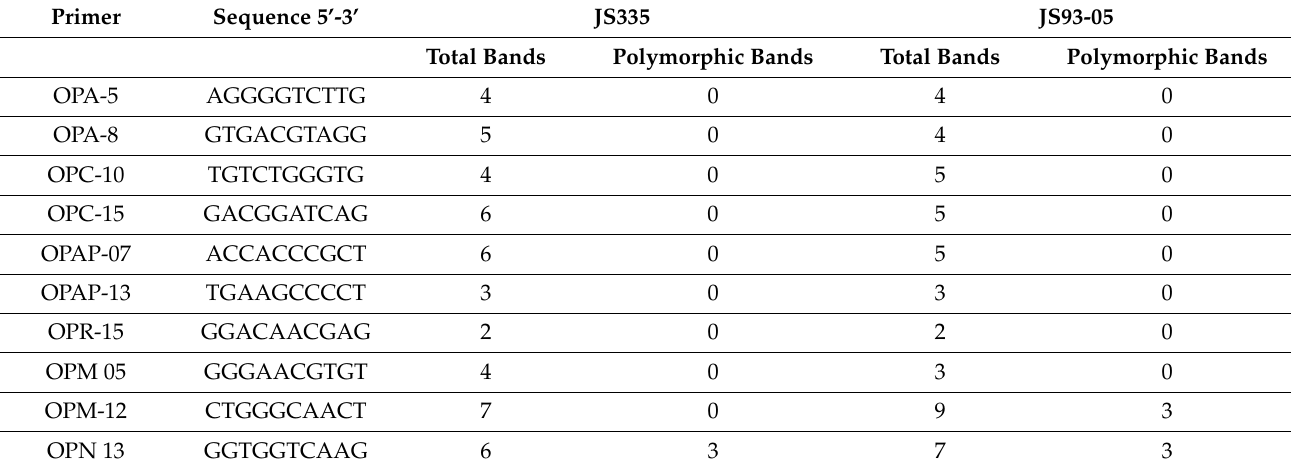
Table 7. Details of RAPD primers used for confirmation of selected putative drought tolerant